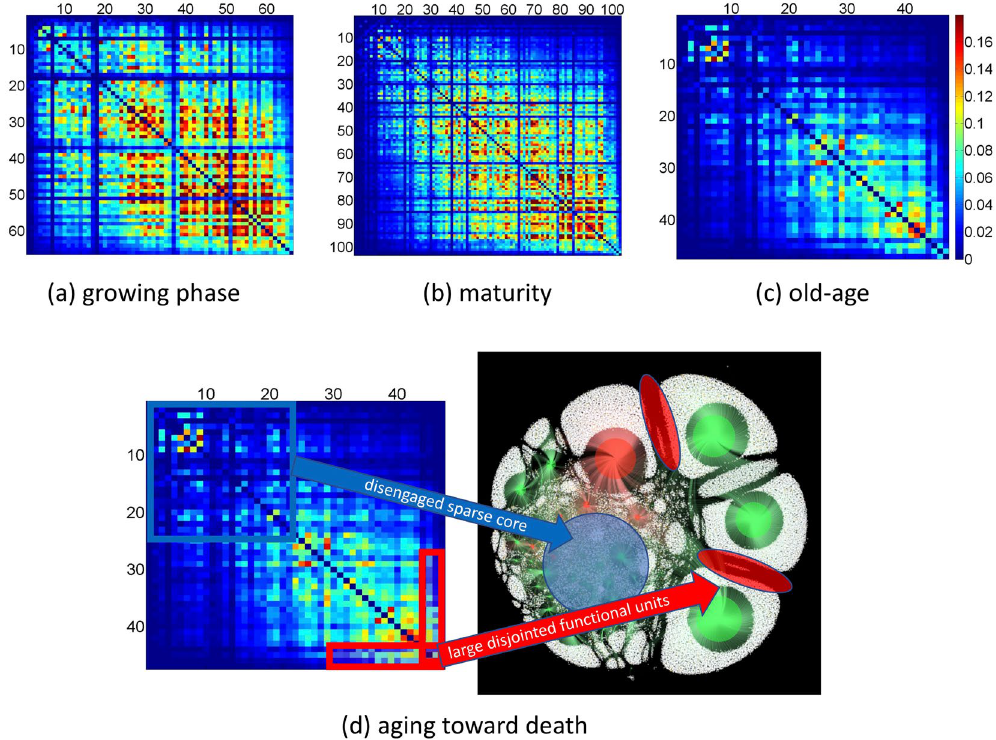
Figure 2. Aging and dying. ( a – c ) Correlation matrices correspond to the snapshots ( a – c ) in Fig. 1. ( d ) Process of dying in terms of behavior of the correlation